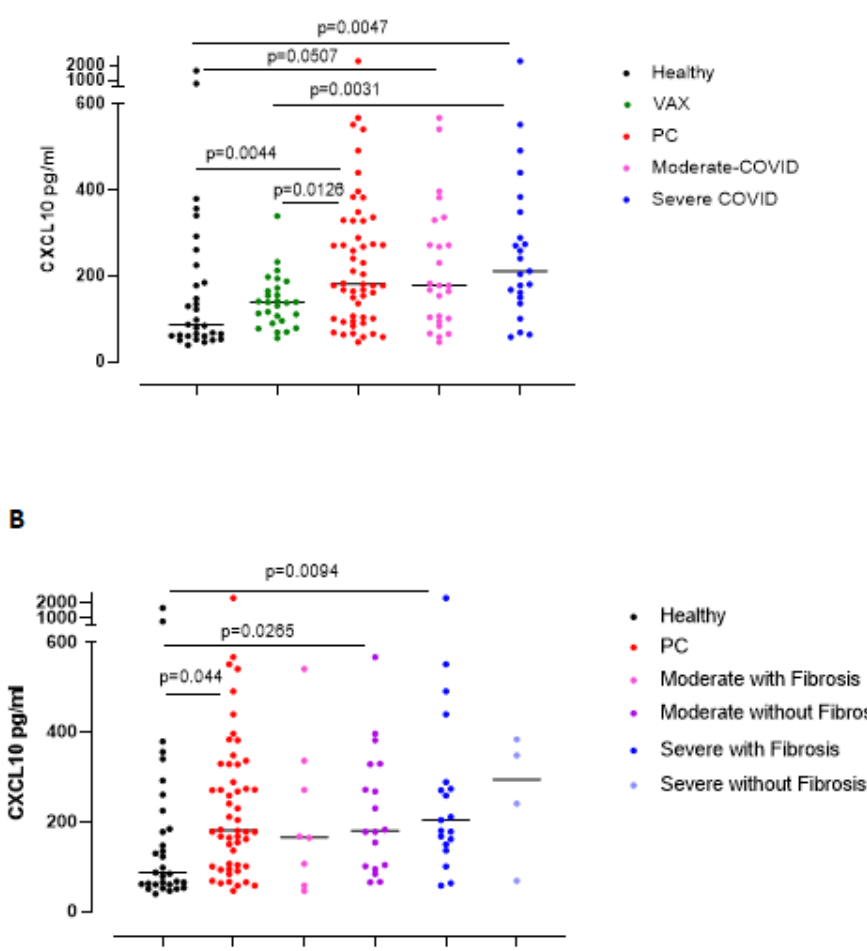
Figure 4. Plasma levels of CXCL10 were increased in PC patients according to the severity of the disease and to the presence of symptoms and signs of lung fibrosis. ( A ) Circulating CXCL10 levels were higher in severe PC patients who developed symptoms and signs of lung fibrosis compared to heathy and VAX subjects (blue dots vs. black and green dots). ( B ) CXCL10 levels were evaluated according to lung fibrosis-like symptoms. Data are expressed as median. Statistical analysis was performed according to the Mann–Whitney U test.